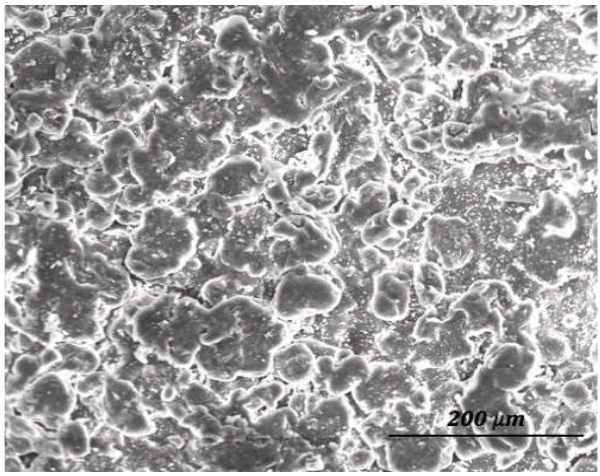
Figure 4. SEM of as received (AR) PA2200.